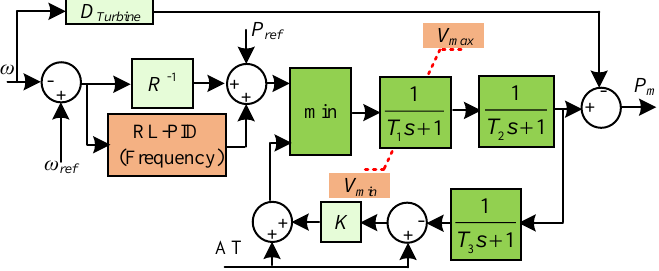
Figure 13. The modified model of the gas turbine of combined heat and power (CHP) with an extra adaptive controller [57].